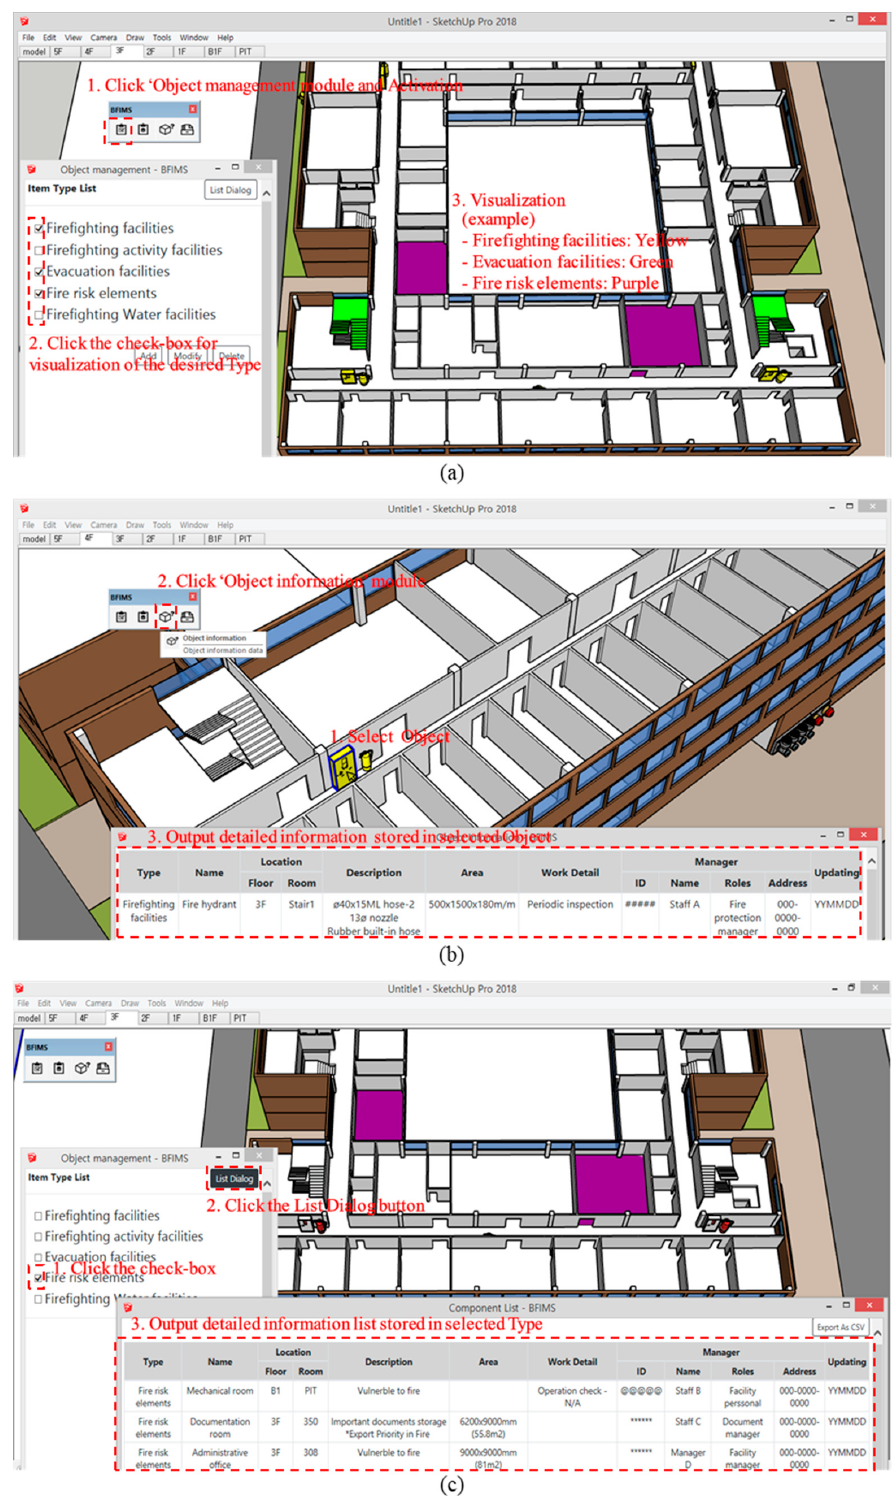
Figure 7. BFIMS implementation: ( a ) Object visualization; ( b ) single object data output; and ( c ) multiple grouped objects data output.